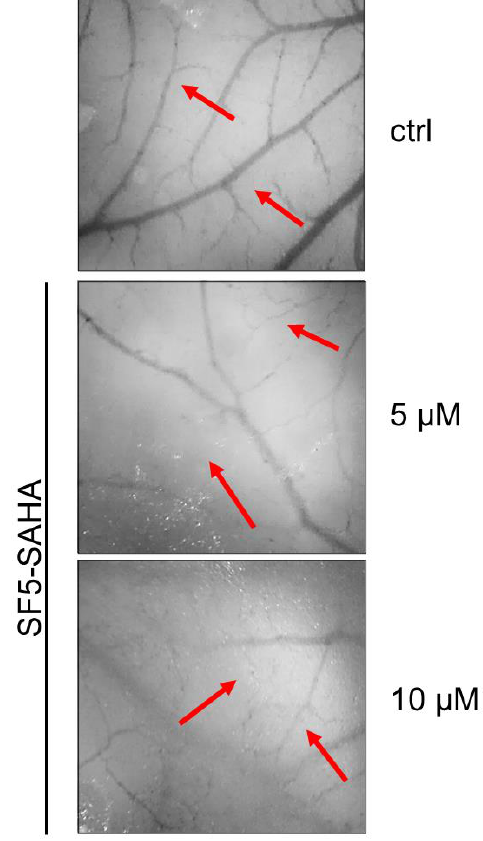
Figure 12. Angiogenesis in fertilized chicken eggs (CAM assay). Representative images of n = 4 independent experiments showing antiangiogenic effects of SF5-SAHA (5 or 10 µM) after 72 h. Control (ctrl) image shows vessels of untreated CAM (PBS control). Red arrows indicate conspicuous branches and vessel diameters.